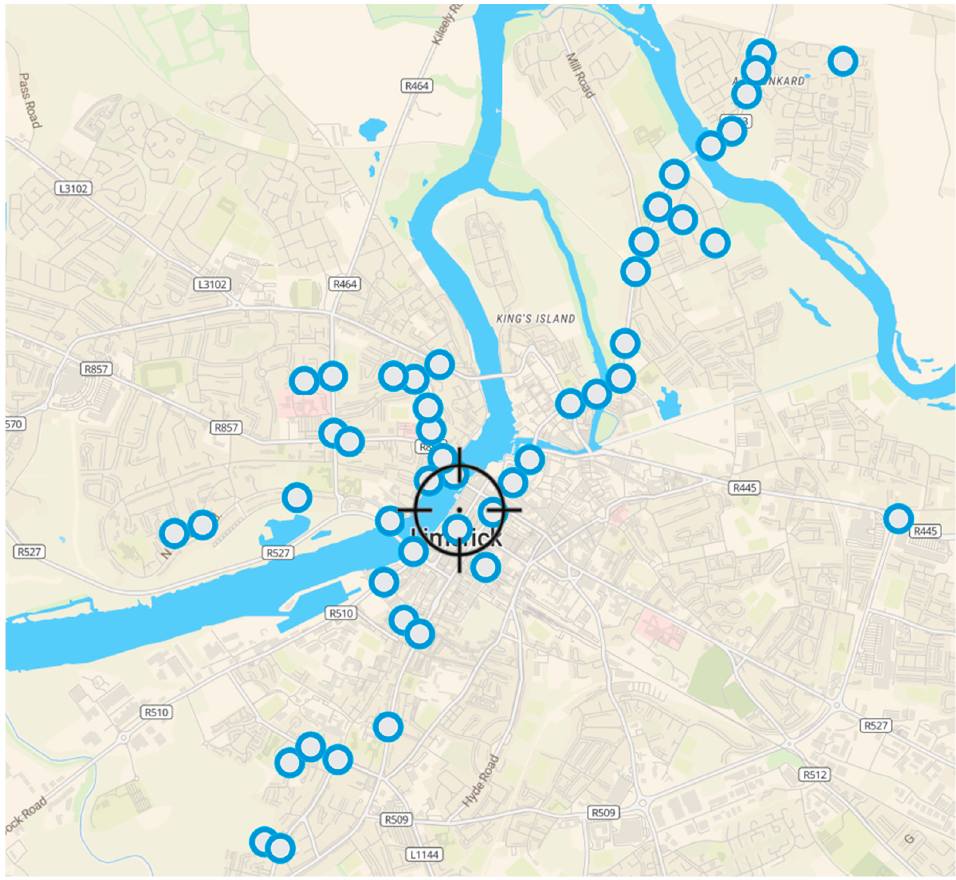
Figure 7. Limerick Innovation Playground Sample citizen mapping project “Safe Routes to School in Limerick,” (Source: [31]).